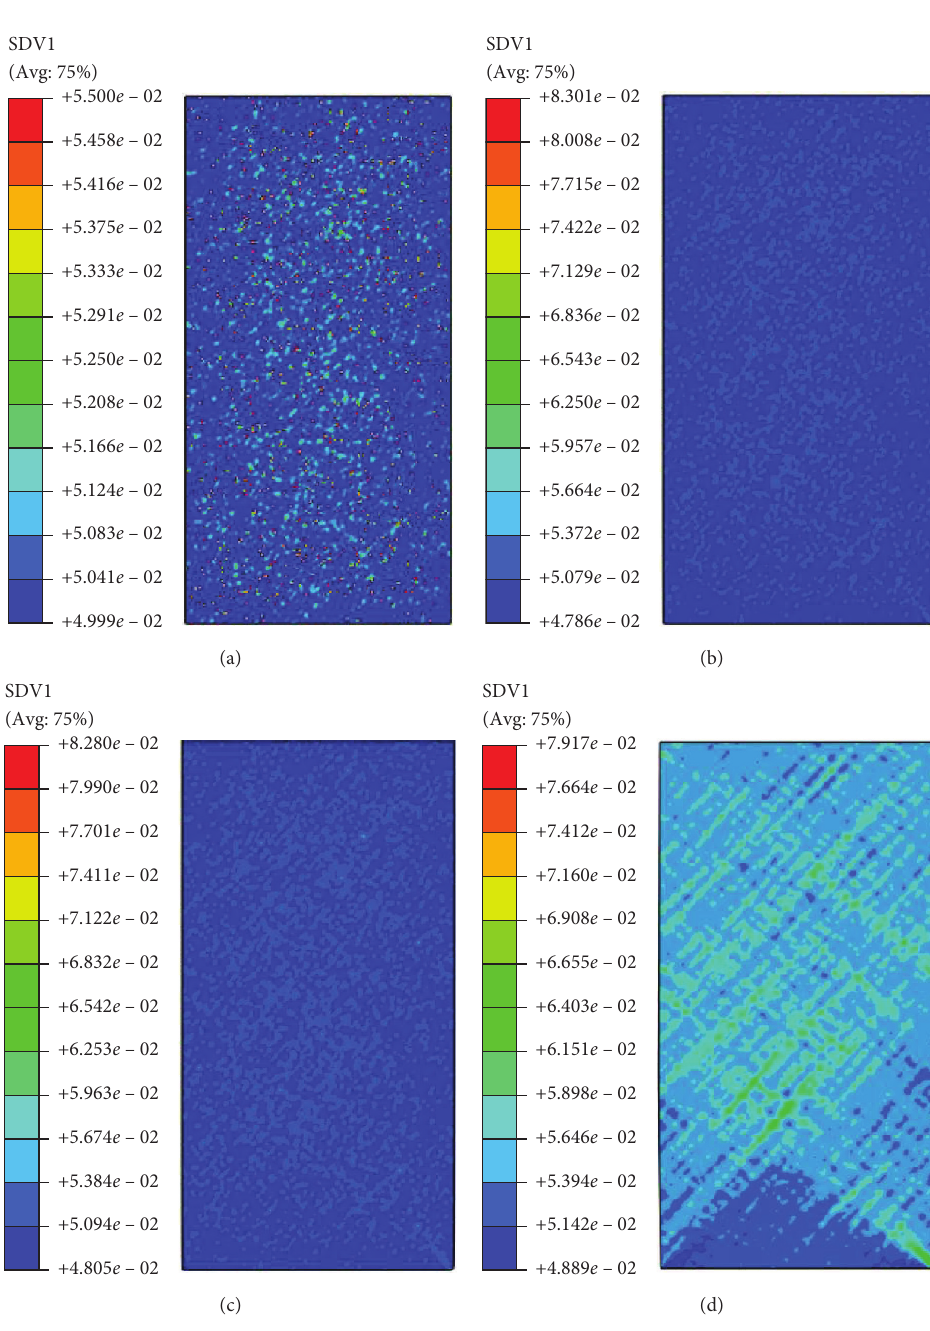
Figure 4: Contours plot of the shear banding evolution in the specimens at different strains under compressive loading. (a) ε � 0%; (b) ε � 2.29%; (c) ε � 2.49%; (d) ε �